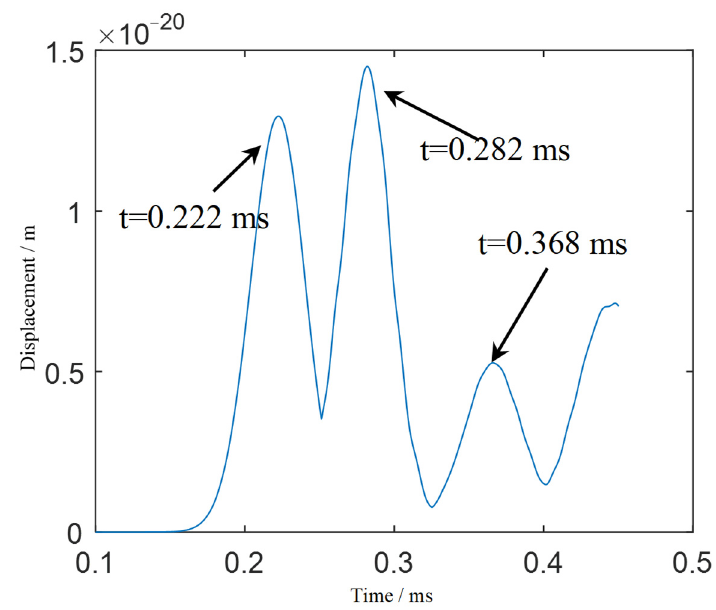
Figure 10. Time-dependent eigenvalue function calculated by local Figure 10. Time ‐ dependent eigenvalue function calculated by local TR ‐ MUSIC.